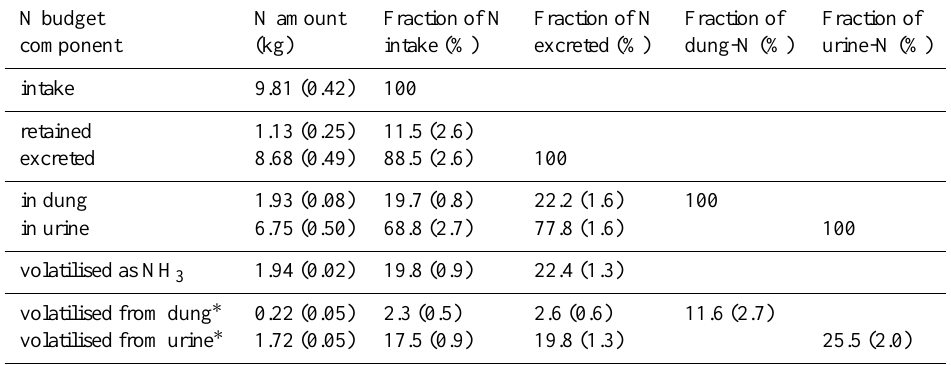
Table 1. Amounts of nitrogen fed, deposited and volatilised as well as their ratios. Uncertainties (in parentheses) are propagated standard errors. N budget N amount Fraction of N Fraction of N Fraction of Fraction of